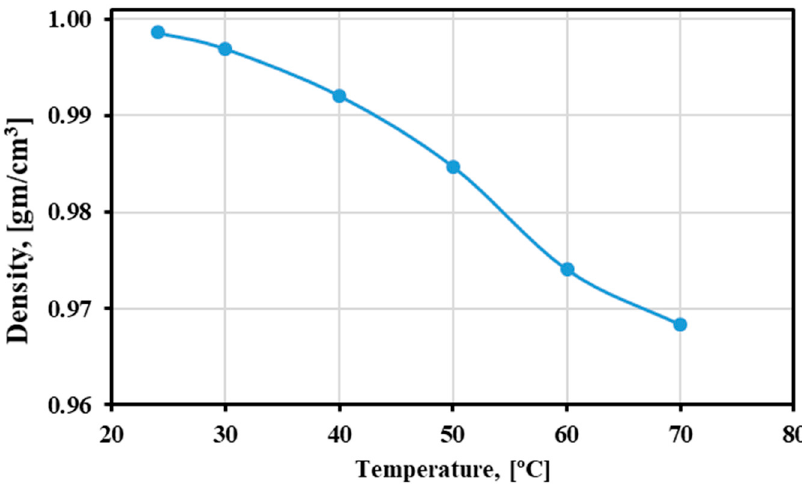
Figure 11. Density measurements of the distilled water with temperature. Table 7. Bulk density and particle density (kg/m 3 ) for particulate materials “as received” and after each thermal treatment. Material